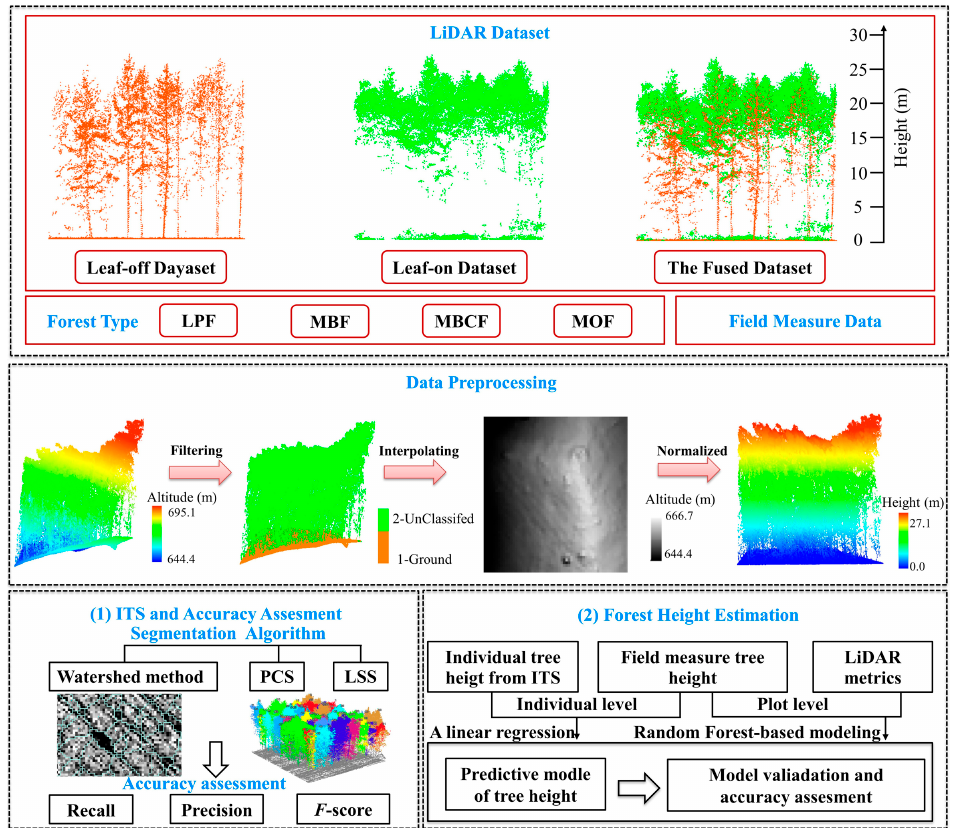
Figure 2. Workflow for data processing and analysis in this study. LPF, larch plantation forest; MBF, mixed broadleaved forest; MBCF, mixed broadleaf-conifer forest; MOF, Mongolian oak forest; PCS: Point cloud segmentation; LSS: Layer stacking segmentation.